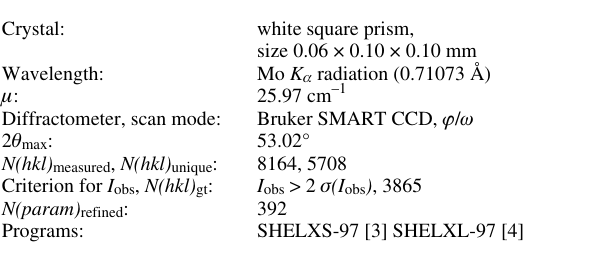
Table 1. Data collection and handling.